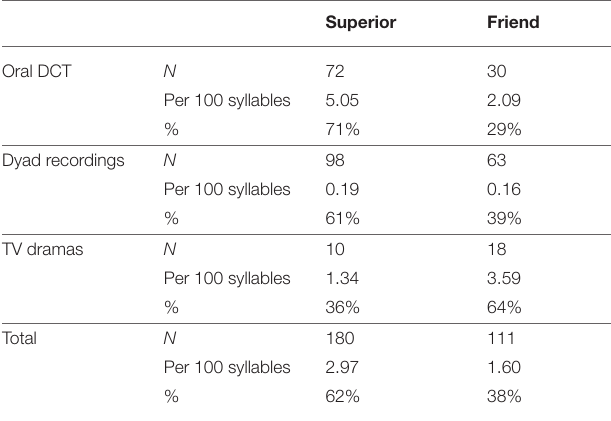
TABLE 1 | Frequency of